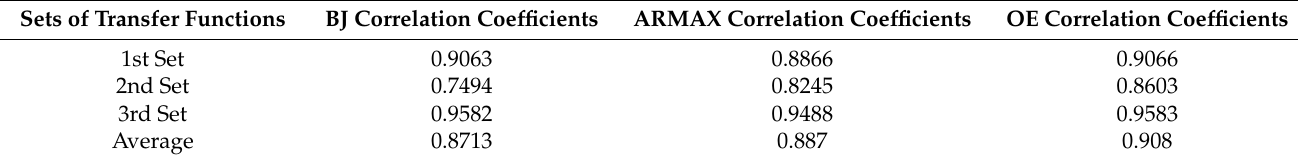
Table 1. R yˆy coefficient of discrete transfer